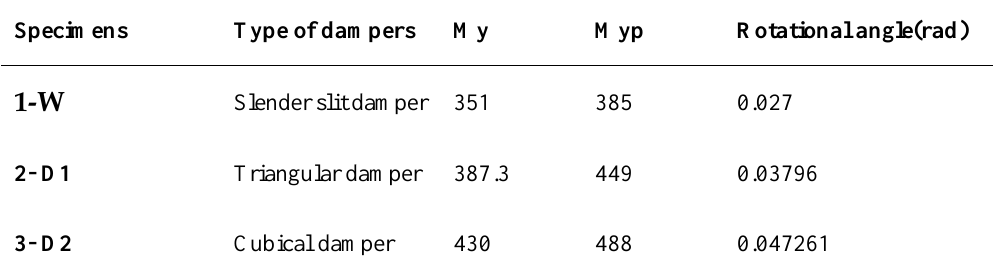
Table 2 . Comparison between experimental results and analytical results